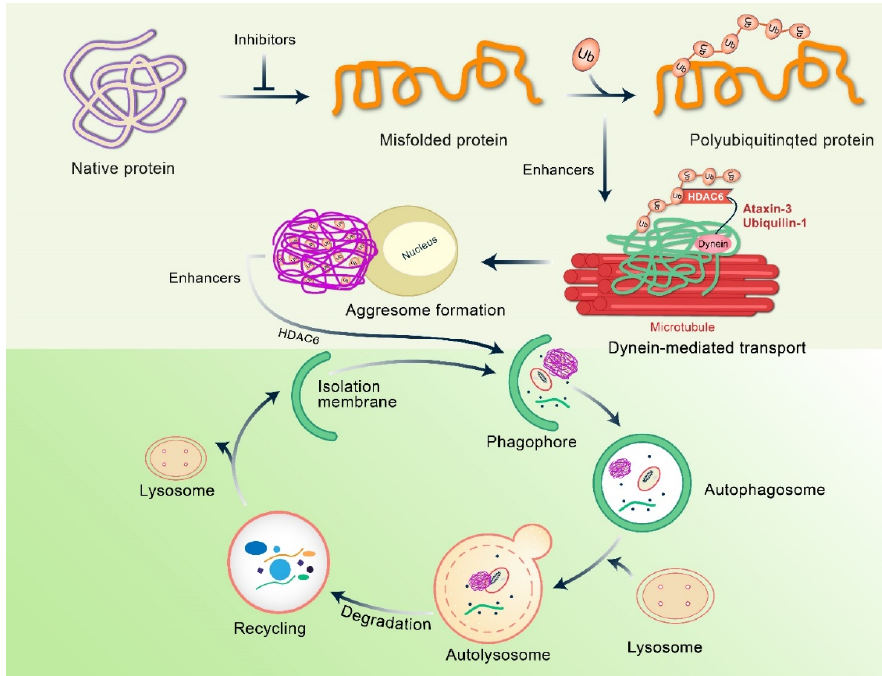
Figure 6. Regulation of misfolded protein by autophagy. Misfolded proteins are recognized and polyubiquitinated by ubiquitin E3 protein ligases. Adapter proteins, such as HDAC6, ataxin3, and ubiquitin-1, bind to polyubiquitinated proteins on the dynein motor complex for retrograde transport to the aggressor. Aggresome takes over the autophagy mechanism, including HDAC6, and breaks down aggresome. Several steps along this path enable small molecules to block incorrect protein folding and improve the coupling of folded proteins to dynein for retrograde transport, or improve the clearance of aggresome by autophagy, which can be potentially applied in the treatment of neurodegenerative